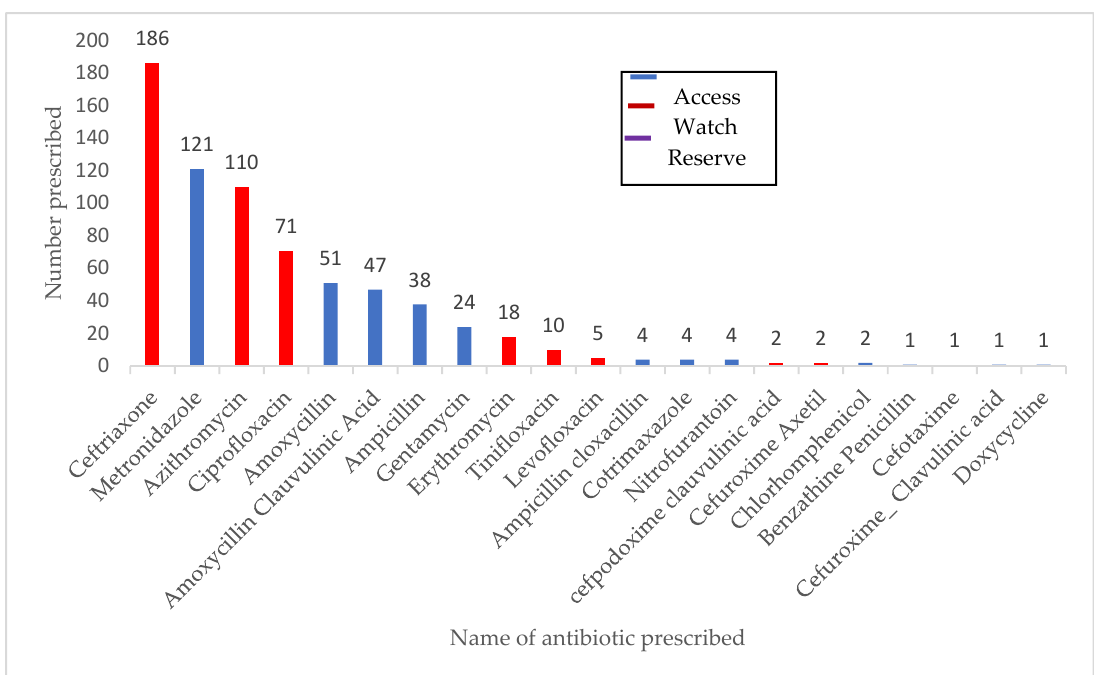
Figure 3. Different antibiotics prescribed to COVID-19 suspected patients admitted to isolation units in Sierra Leone, March 2020–March 2021 (N = 703).